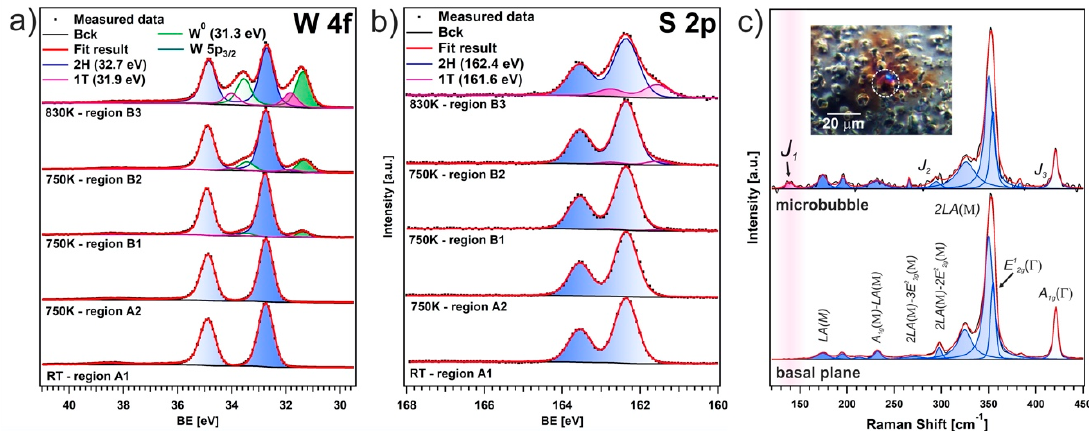
Figure 4. Single energy distribution curves of µ -PE spectra of the W 4f ( a ) and S 2p ( b ) core levels, taken during the in situ annealing process on the regions indicated in Figures 2 and 3. ( c ) Micro-Raman spectra obtained on the basal plane and microbubble region under 532 nm excitation with a spot diameter of about 1.1 µ m and an incident power of 100 µ W; inset: optical micrograph that shows a microbubble region (white dashed circle).